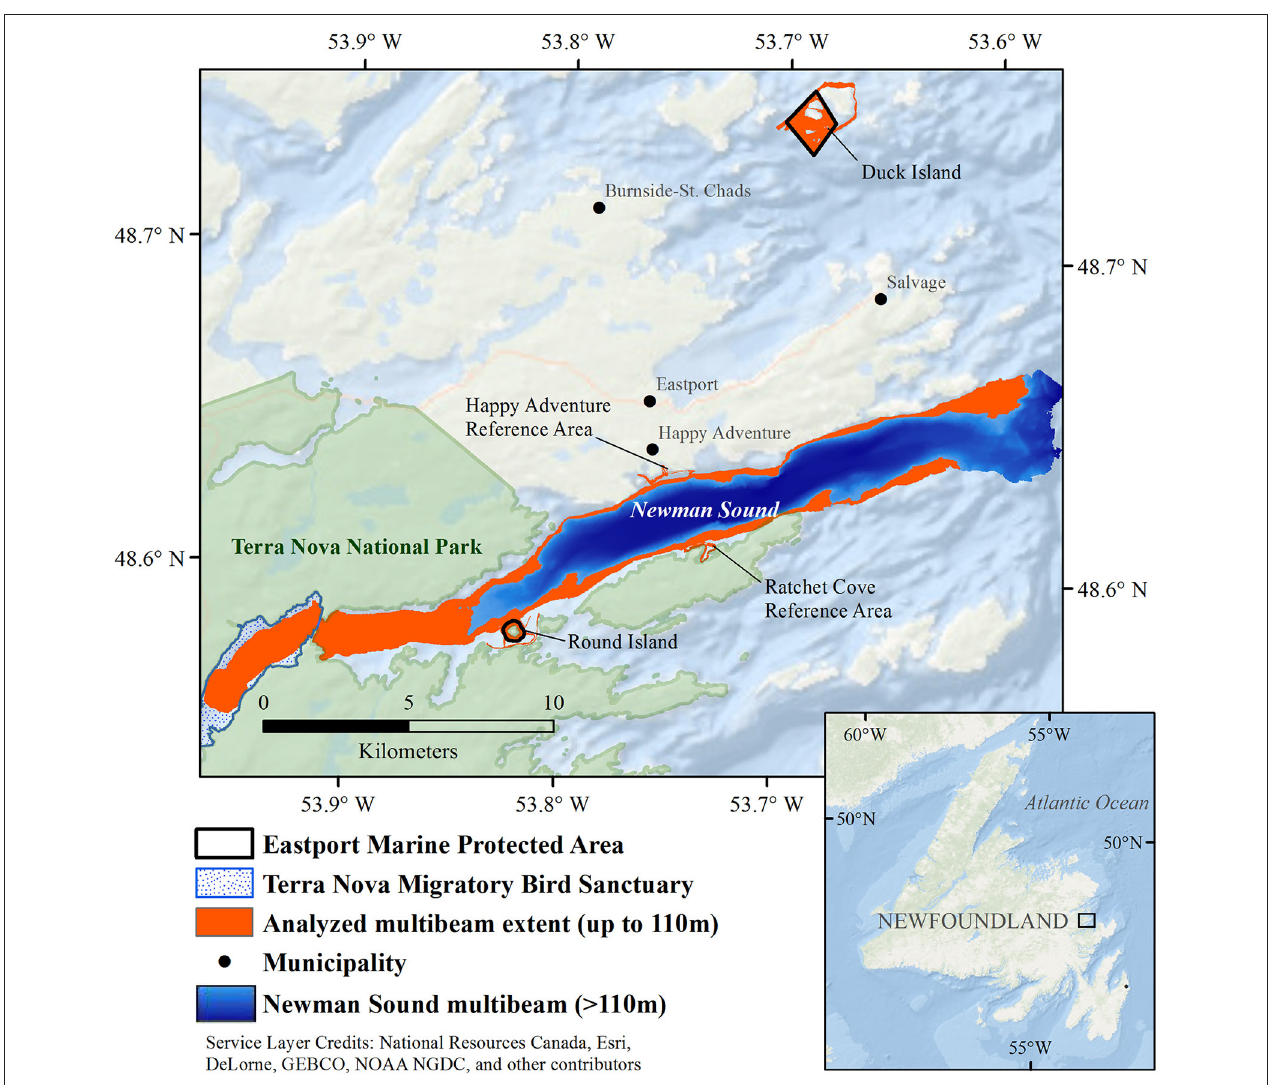
FIGURE 1 | Newman Sound and the Eastport Marine Protected Area closures, Bonavista Bay,